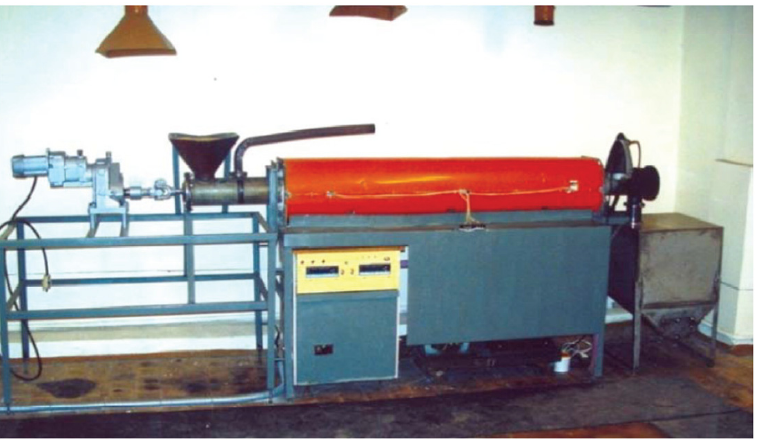
Figure 10. Pilot setup for flame carbonization of diverse raw plant materials. Reprinted with permission from Ref. [45]. Copyright 2012, IntechOpen .